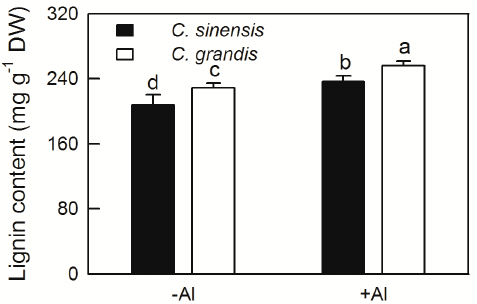
Figure 3. Effect of Al treatment on lignin content in roots of C. sinensis and C. grandis . Bars represent means ± SD ( n = 4). Different letters above the bars indicate a significant difference at p < 0.05.